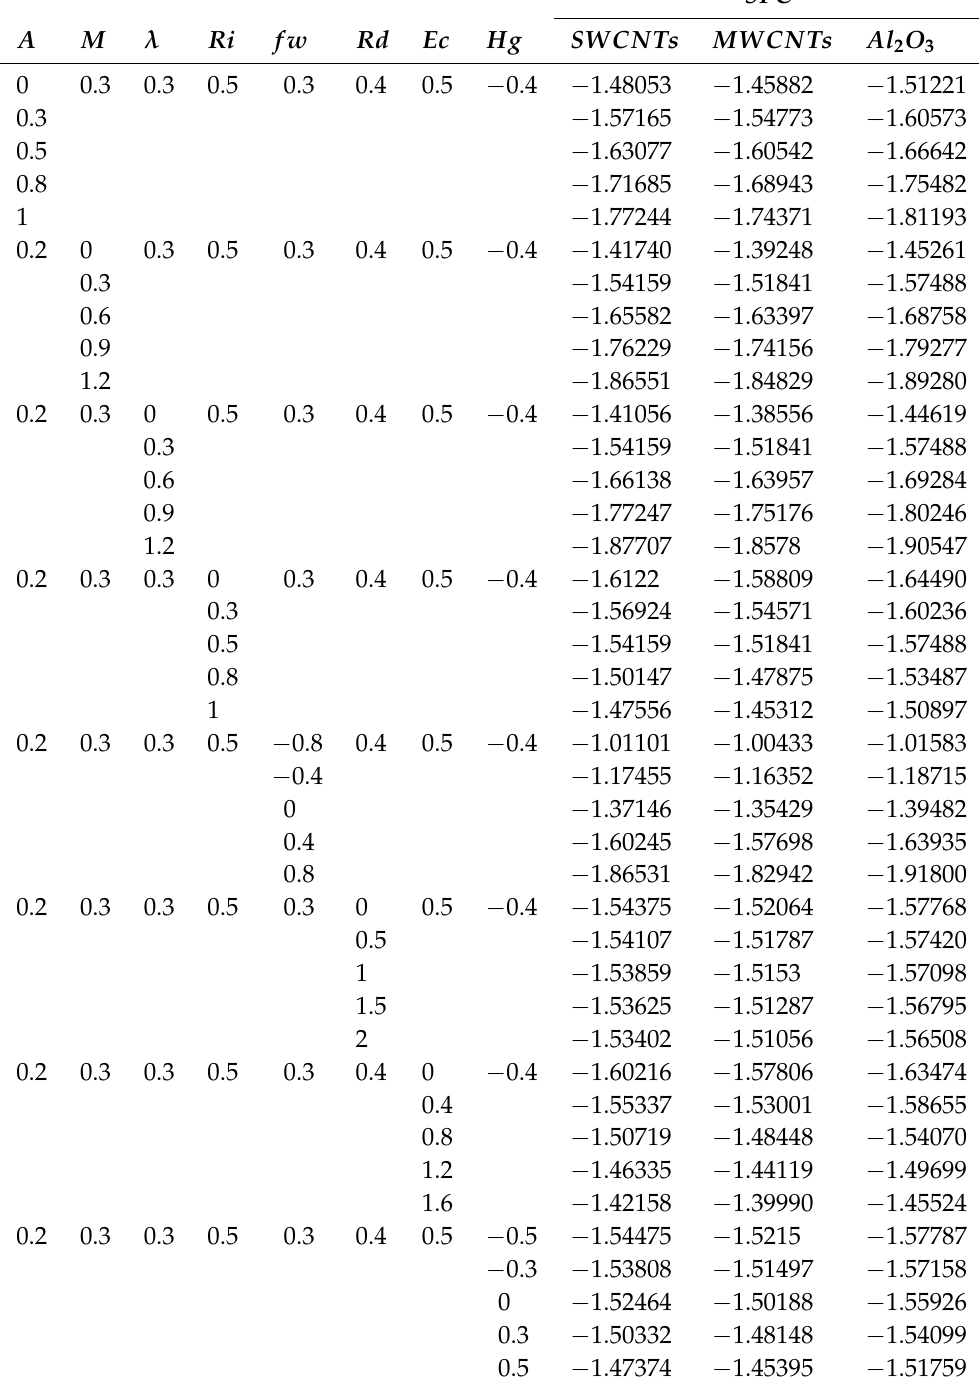
Table 5. The SFC for various values of A , M , λ , Ri , fw , Rd , Ec and Hg